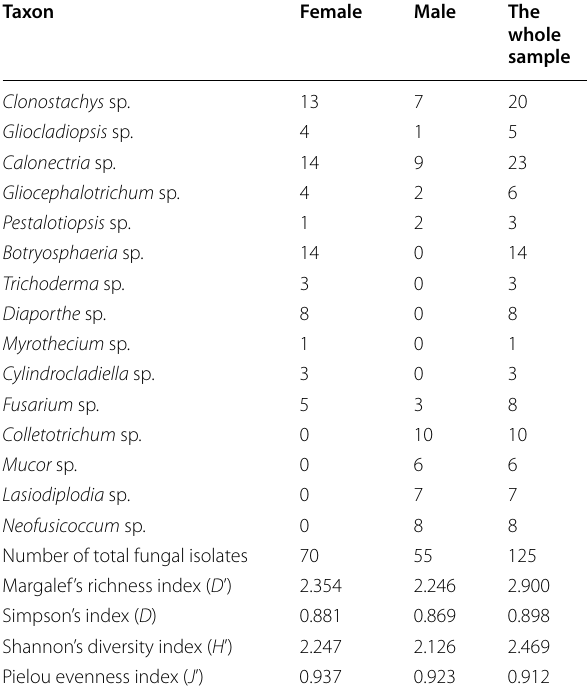
Table 2 Diversity of endophytic fungi isolated from B . polyandra